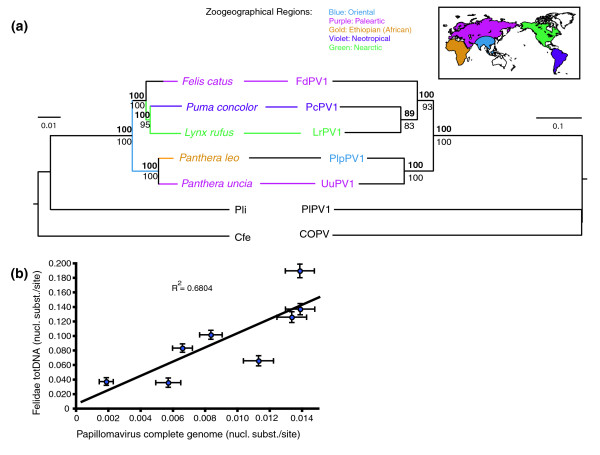
Phylogenetic relations among felid species and their papillomaviruses. (a) Co-evolutionary relationships revealed by the feline multigene (left) and papillomavirus (PV) complete coding genome (right) phylogenetic trees. Identical tree topologies were reconstructed by using both maximum likelihood (ML) and Bayesian methods for all data sequences from Johnson and coworkers [12] and for the amino acid translation of the concatenated PV genes. Bayesian posterior support values (bold) and ML bipartition values for relationships are shown on the branches. The scale bars indicate the genetic distance (nucleotide substitutions per site). Scientific names and branches in the host phylogenetic tree are color coded to depict recent and historic zoogeographic regions shown on the map (Oriental, Palearctic, Ethiopian, Neotropical, and Nearctic), as inferred by Johnson and coworkers [12] from current distributions, fossil records, and phylogenetic analysis. Branches in black reflect either less certain historical interpretations or geographic distributions beyond one. For the viral phylogenetic tree, the same color code is used for the abbreviated virus name, depicting the geographical region from which the respective virus was isolated. Outgroups are Prionodon linsang (Pli) and Cryptoprocta ferox (Cfe) in the host tree, and Procyon lotor PV type 1 (PlPV1) and canine oral PV (COPV) in the virus tree. (b) Branch length correlation (nucleotide substitutions per site) for the feline and PV phylogenetic trees. Outgroup lineages were excluded from this analysis. FdPV1, Felis domesticus PV type 1; LrPV1, Lynx rufus PV type 1; PcPV1, Puma concolor PV type 1; PlpPV1, Panthera leo persica PV type 1; UuPV1, Uncia uncia PV type 1.